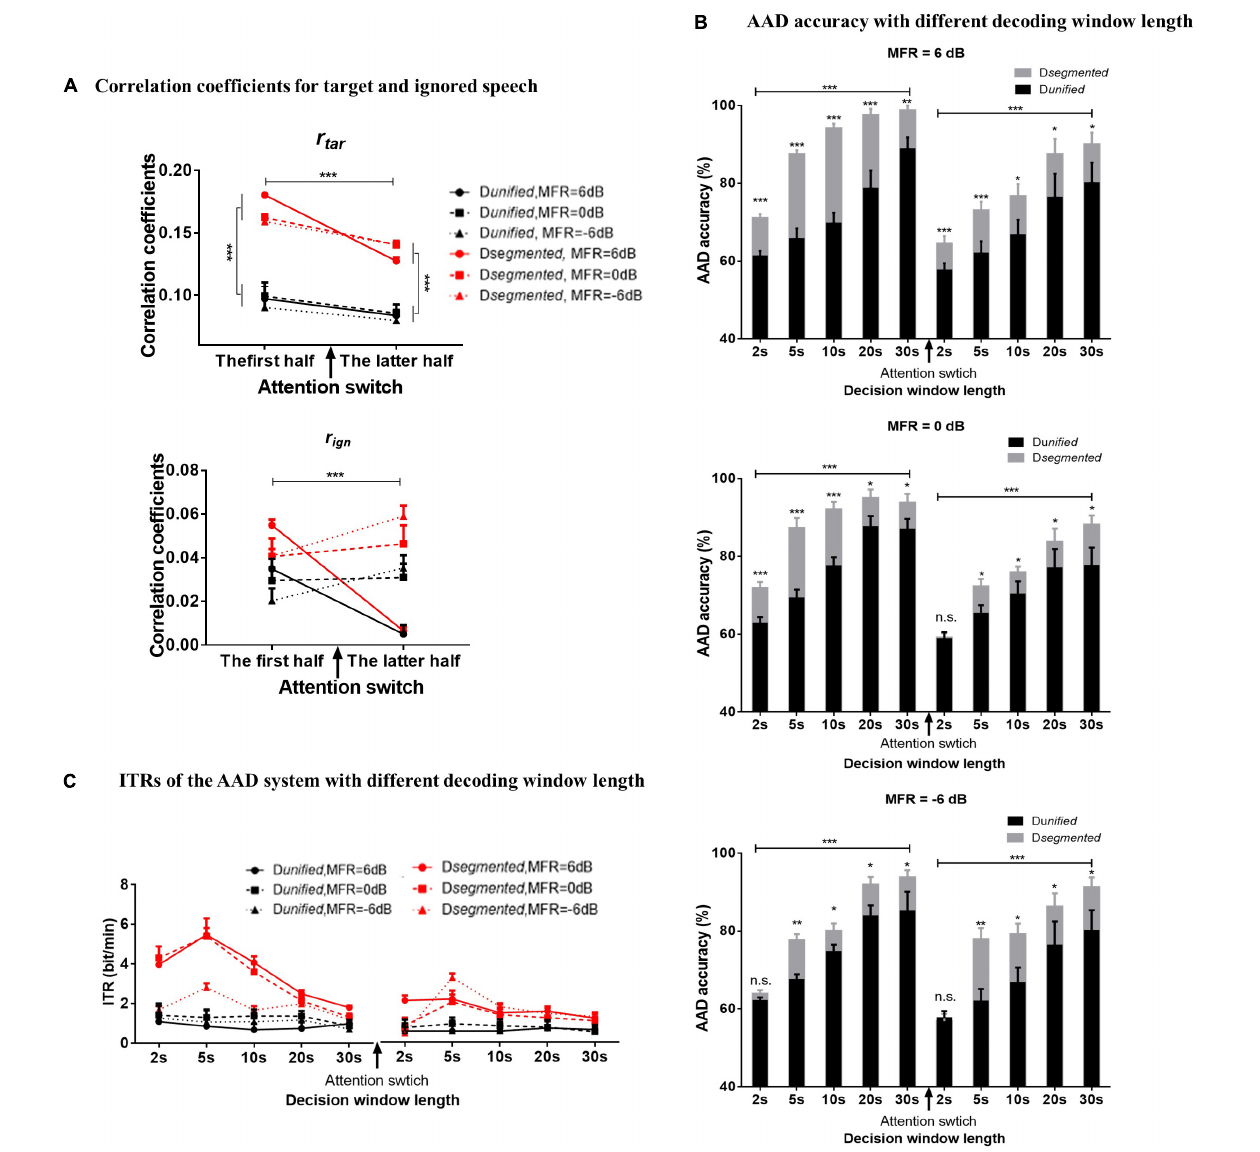
FIGURE 4 | (A) The correlation coefficients of the reconstructed speech envelopes with the target speech envelope (the above figure) and the ignored speech envelopes (the below figure) decoded with the D segmented (red lines) and D unified (black lines) computational models in 6-dB (solid lines with circle signs), 0-dB (dashed lines with square signs), and –6-dB (dot lines with rectangular signs) MFR conditions in the first half and the latter half. (B) The AAD accuracy calculated by D segmented (gray boxes) and D unified (black boxes) with 2–, 5–, 10–, 20–, and 30-s decoding window lengths before and after the switching of auditory attention in 6–, 0–, and –6-dB MFR conditions. The error bars show the standard error in each condition, *** indicates P < 0.001, ** indicates P < 0.01, * indicates P < 0.05, and n.s. indicates P > 0.05. (C) ITR with the D segmented (red lines) and D unified (black lines) with 2, 5, 10, 20, and 30 s decoding window lengths before and after the switching of the auditory attention in 6–, 0–, and –6-dB MFR conditions.